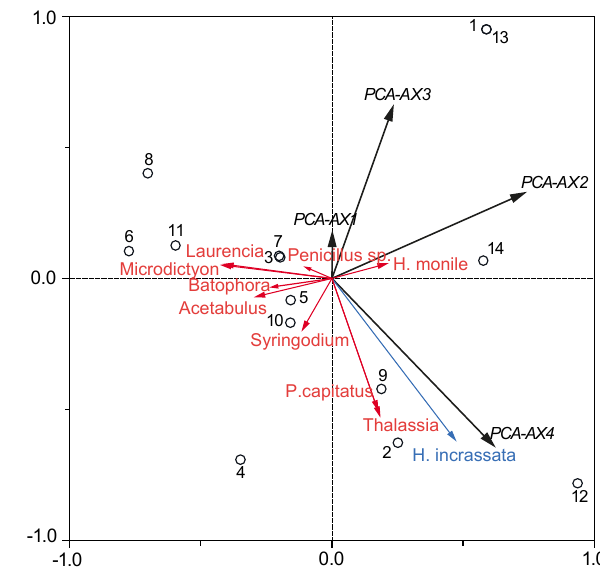
-1.0 Figure 6. Partial RDA plot demonstrating the total sedimentary foraminiferal assemblage against the absolute macrophyte biomass, including the 0.25–0.5mm grain size fraction as a co-variable. Black circles show each of the sample sites (GH12-01 to GH12- 14), with sample sites GH12-01 and GH12-13 showing identical scores. The black vectors comprise four PCA axes (PCA-AX1 to PCA-AX4), covering all species of the thanatocoenosis. The most abundant macrophyte species are shown as red and blue vectors. Ex- clusively the macrophyte species H. incrassata (singled out as the blue vector) was statistically significant for the faunal variability of the total foraminiferal